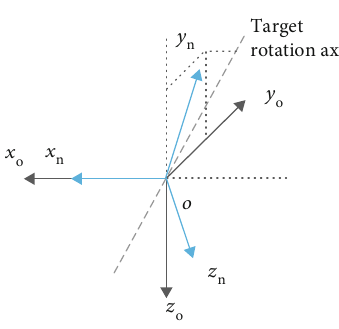
Figure 7: Training coordinate system. The subscript “ o ” denotes the orbital coordinate system S o , and the subscript “ n ” denotes the training coordinate system S n